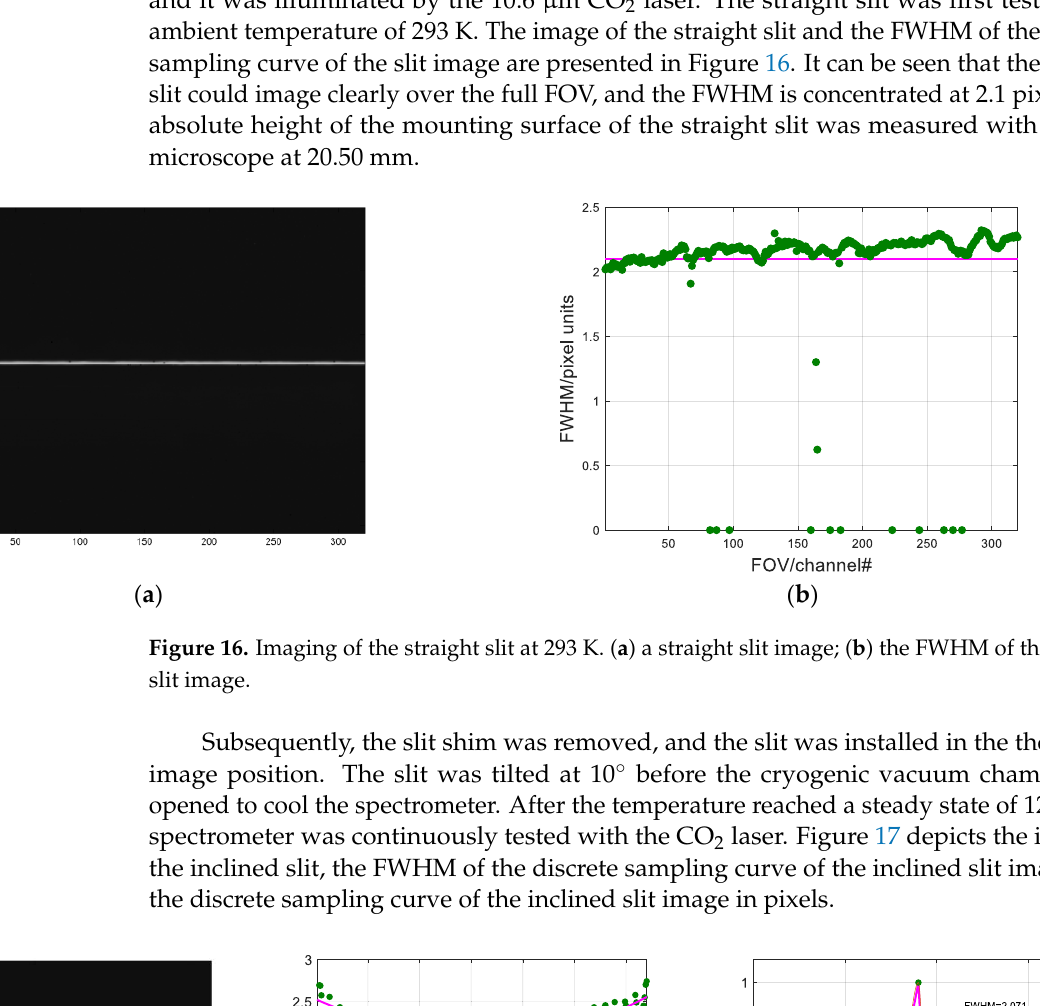
Figure 15. Principle diagram of the measurement under a tool microscope.